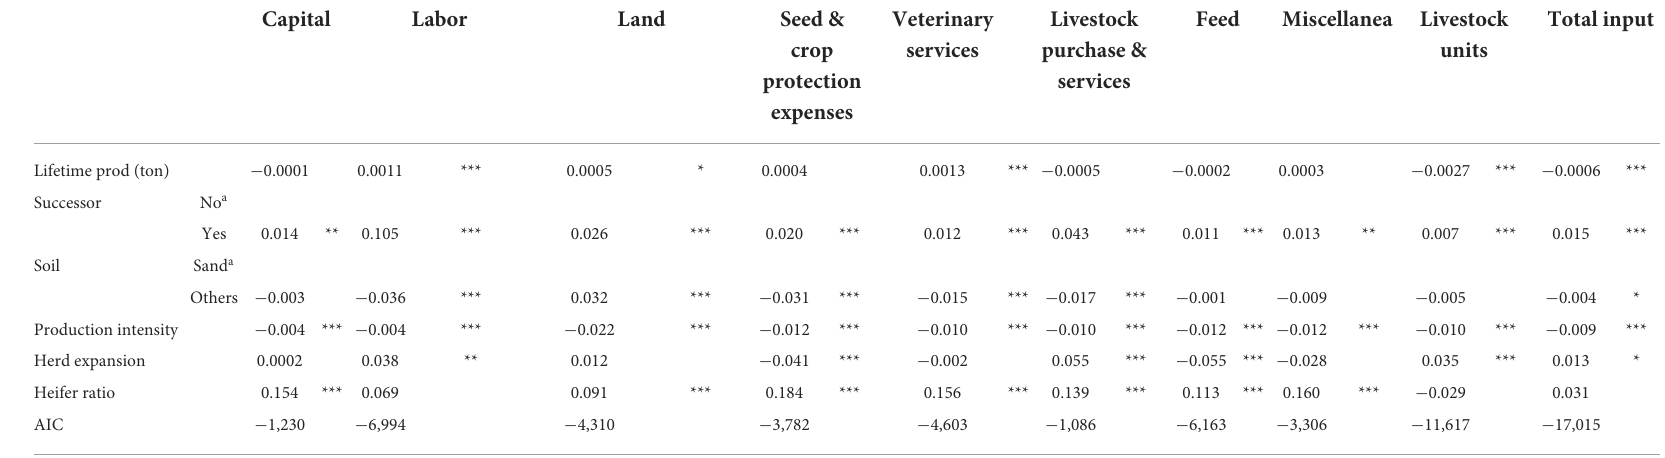
TABLE 5 The results of bootstrap truncated regression models on technical inefficiency for, respectively, capital, labor, land, seed & crop protection expenses, veterinary services, livestock purchase & services, feed, miscellanea, livestock units, and total input with lifetime milk production as longevity